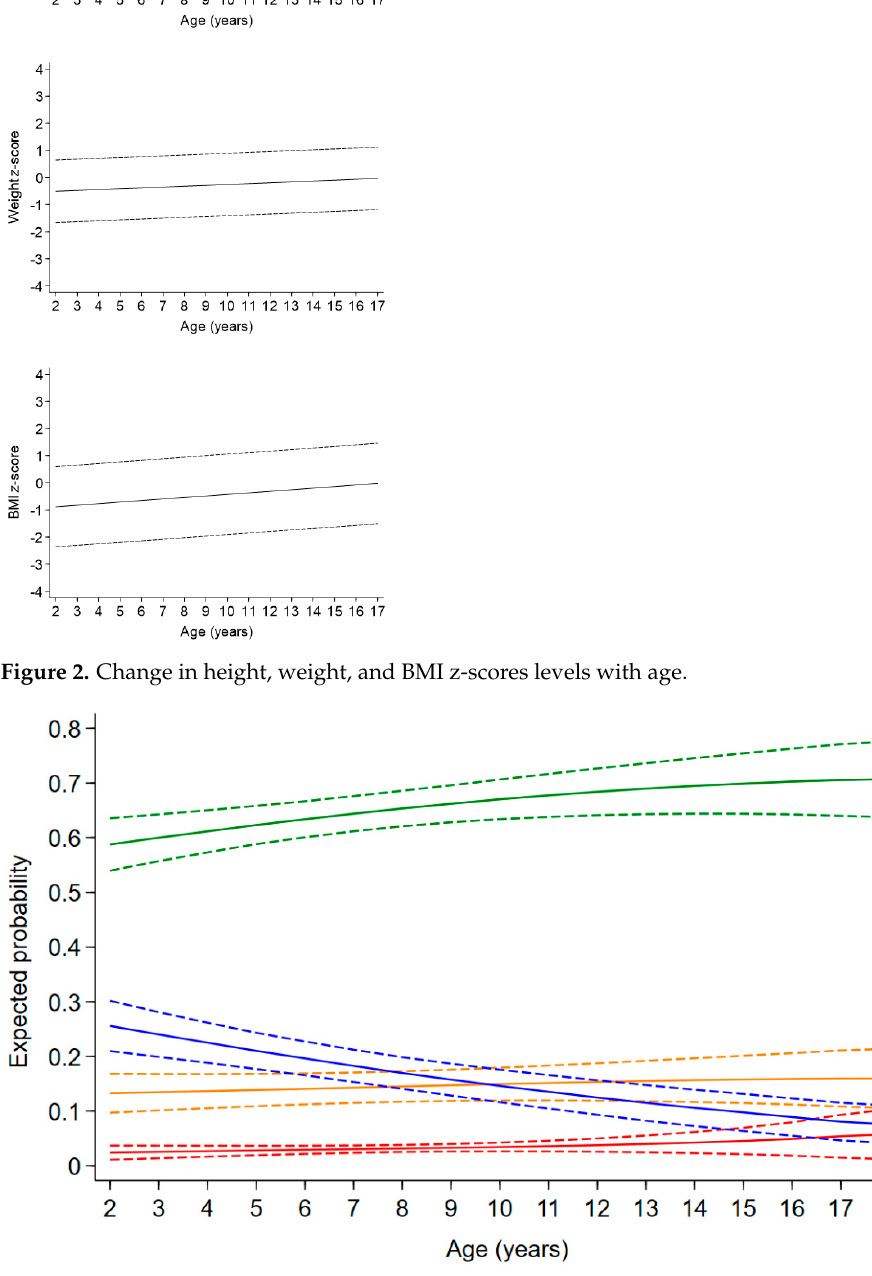
Figure 3. Change in expected probability of underweight (blue), normal weight (green), overweight (orange), and obesity (red) children with (orange), and obesity (red) children with age.